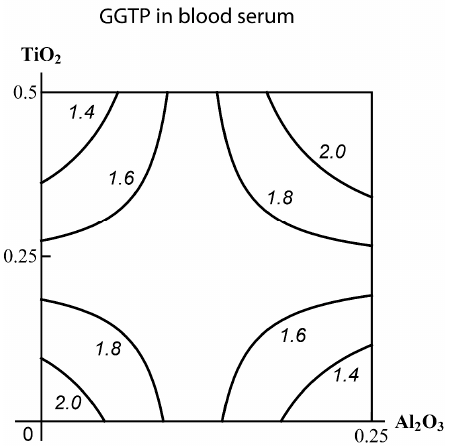
Figure 3. The ambiguity of the TiO 2 -NP + Al 2 O 3 -NP combined subchronic toxicity type assessed by a decrease in the GGTP content of blood serum: subadditivity of unidirectional action at low doses and relatively high levels of effect; superadditivity at high doses and similar levels of effect; opposite action at low doses and relatively low levels of effect and also at high doses and relatively low doses of effect. The axes represent doses of corresponding MeO-NPs in mg per rat; the numbers at the isoboles denote the magnitude of the effect (in IU/L).